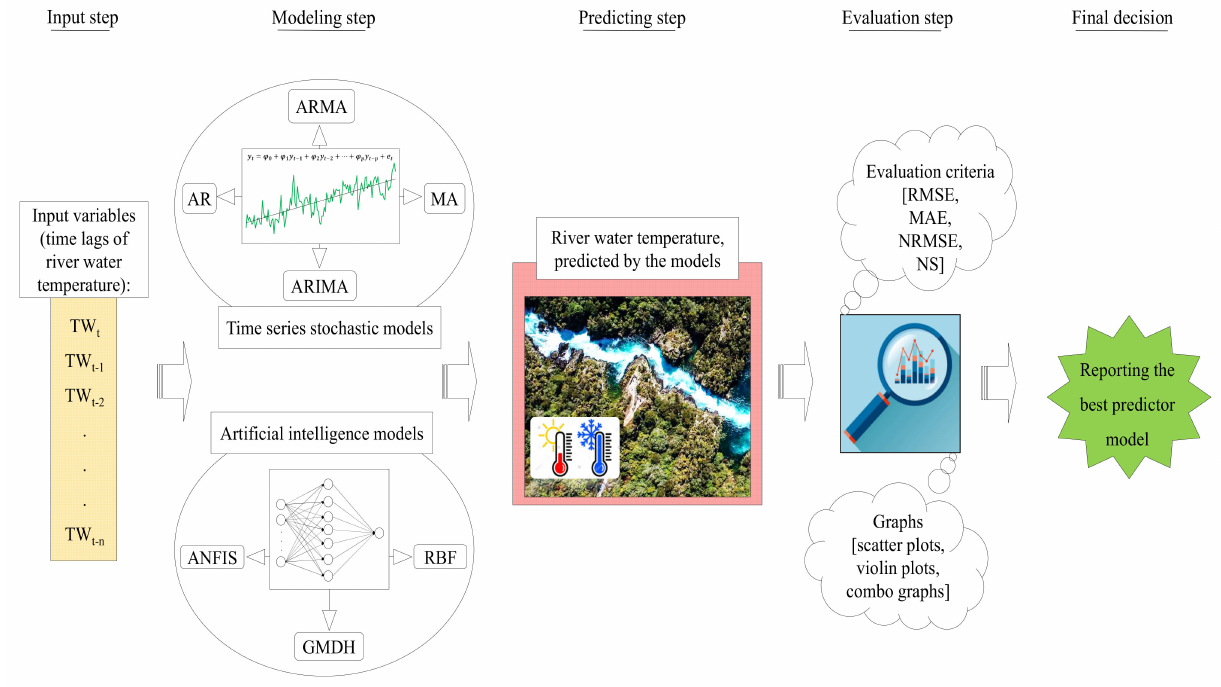
Figure 5. Flowchart of the modeling and prediction